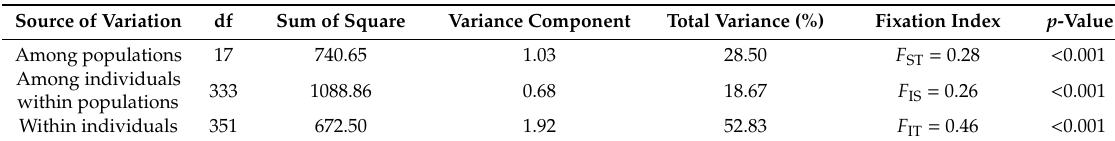
Analysis of molecular variance (AMOVA) of C. hemipterus as inferred from eight microsatellite